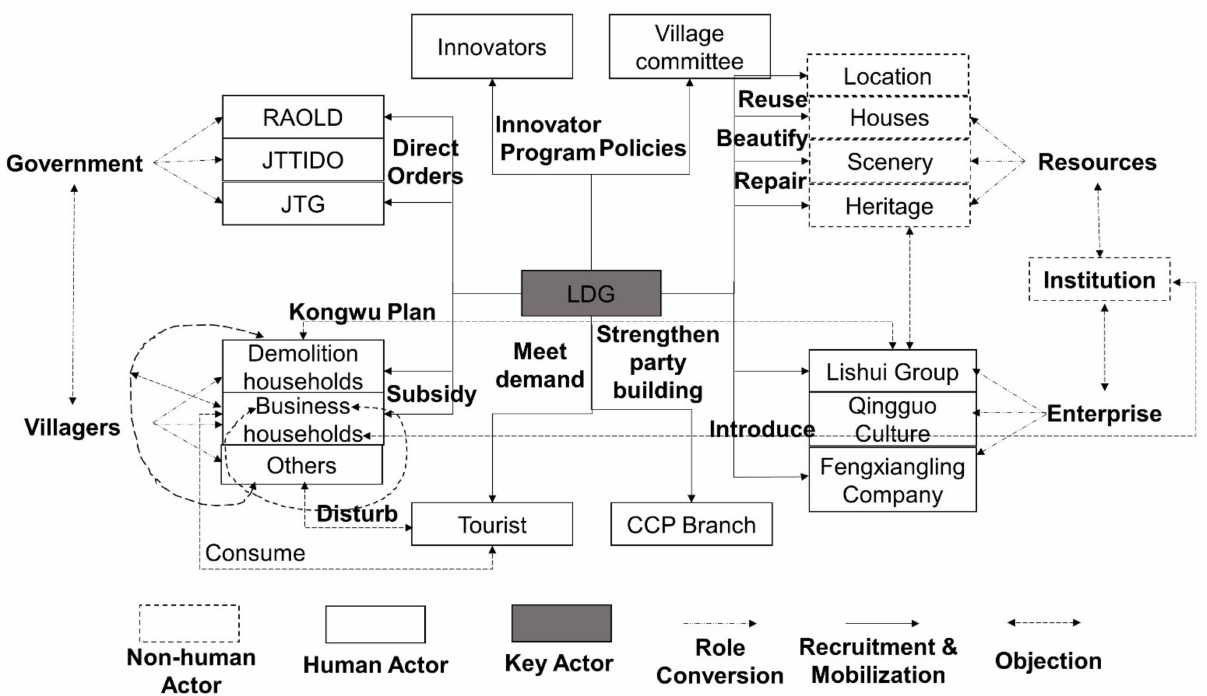
Figure 5. Actor-network for Shishanxia space